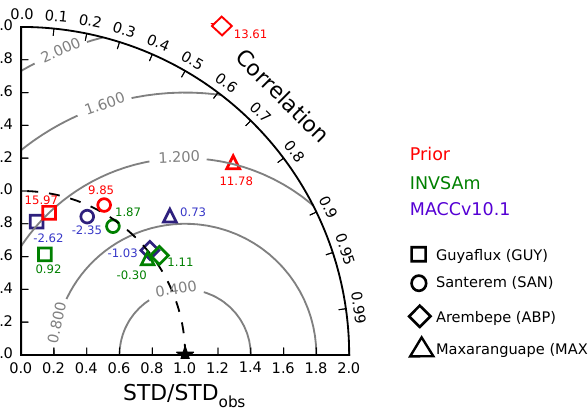
Figure 5. Taylor diagram of the statistics of misfits between ob- servations and simulated CO 2 mole fractions between 12:00 and 15:00LT at Guyaflux (square), Santarém (circle), Arembepe (dia- mond) and Maxaranguape (triangle), when wind speed > 2ms − 1 , using prior fluxes (red), INVSAm (green) and MACCv10.1 (pur- ple). Radial distance from the origin: ratio of SD of simulated mole fractions and SD of the observations. Angle measured from the y axis: coefficient of correlation. Numbers next to the symbols: bias (in ppm). Grey circles: SD of the misfits (in ppm).